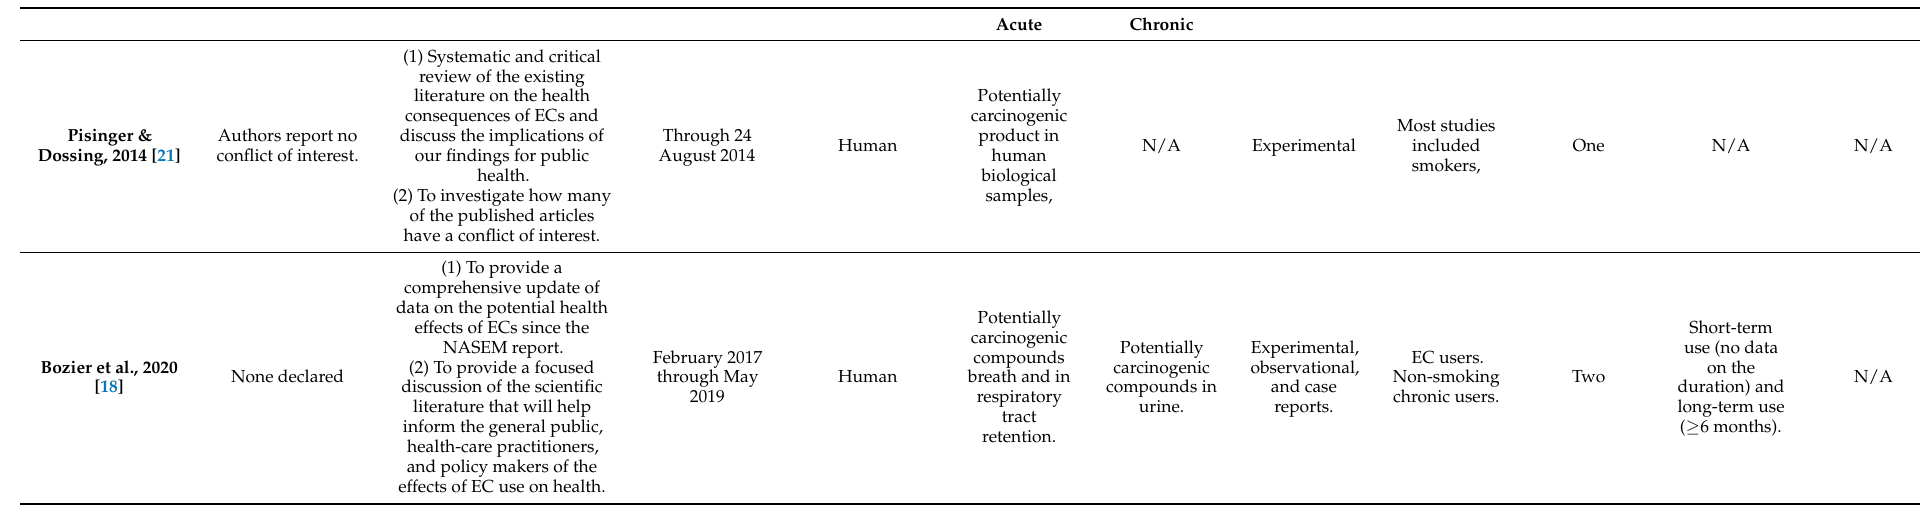
Table 3. Characteristics of systematic reviews on carcinogenic risks of